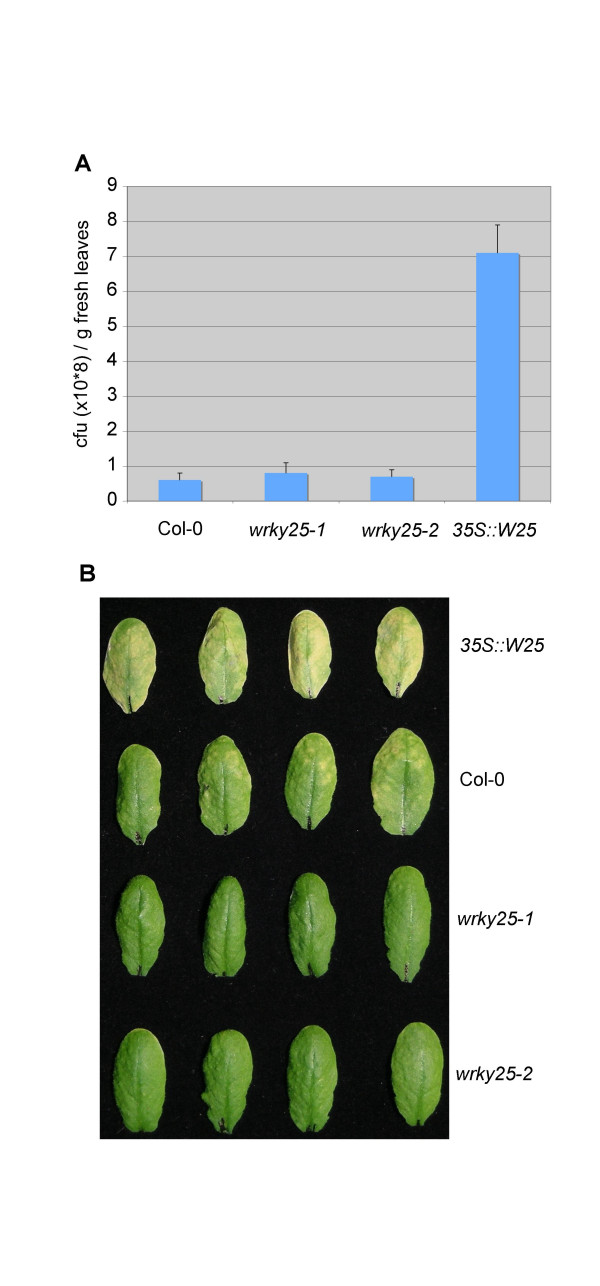
Responses of the wrky25 mutant and transgenic 35S:WRKY25 plants to P. syringae. A. Bacterial titer in wild type (Col-0), wrky25 insertion mutant and F3 progeny of transgenic 35S:WRKY25 plants (line 12) at 3 days post inoculation (dpi) with PsmES4326 (OD600 = 0.0001). The means and standard errors were calculated from six replicates. Analysis of F3 progeny from 35S:WRKY25 line 18 yielded similar results to those observed for 35S:WRKY25 line 12. B. Disease symptom development in wild type (Col-0), wrky25 mutants and transgenic 35S:WRKY25 plants inoculated with PsmES4326 (OD600 = 0.0001). Pictures of representative inoculated leaves were taken at 4 dpi. These experiments were repeated two additional times with similar results.